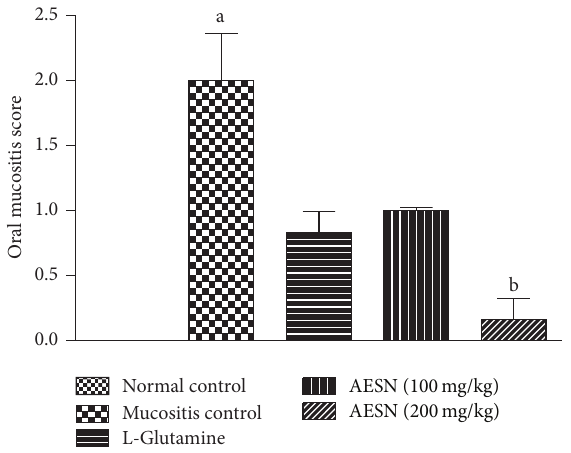
Figure 9: Methotrexate induced oral mucositis score. Oral mucosi- tis score was measured on a scale of 0 to 3. Scores were analyzed using Kruskal-Wallis test followed by Dunn’s multiple comparison tests. All values are expressed as mean ± SEM of 6 animals. a 𝑃 < 0.05 versus normal control, b 𝑃 < 0.05 versus mucositis control.